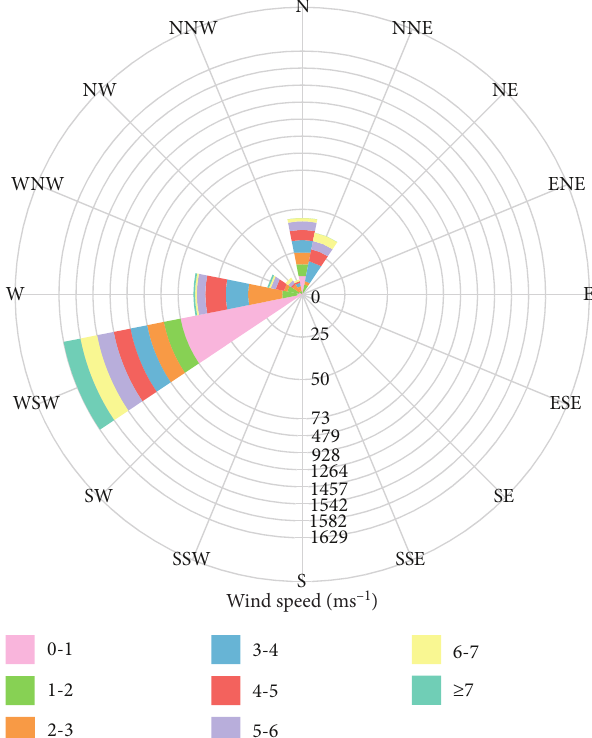
Figure 3: Wind speed and direction per hour. The numbers on the diagram are nonevenly spaced scale